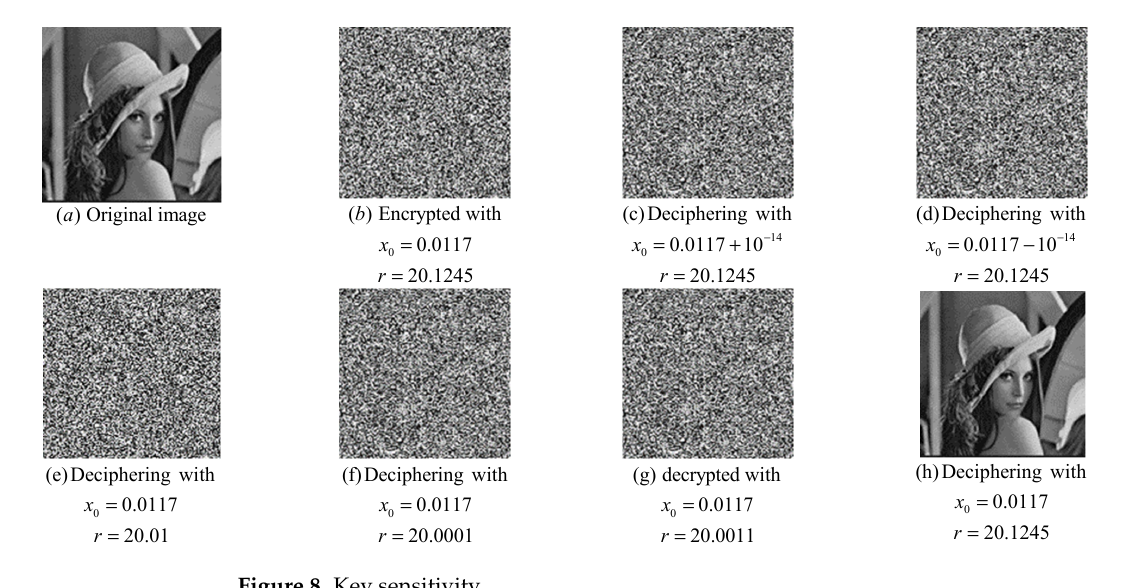
Figure 8. Key sensitivity.